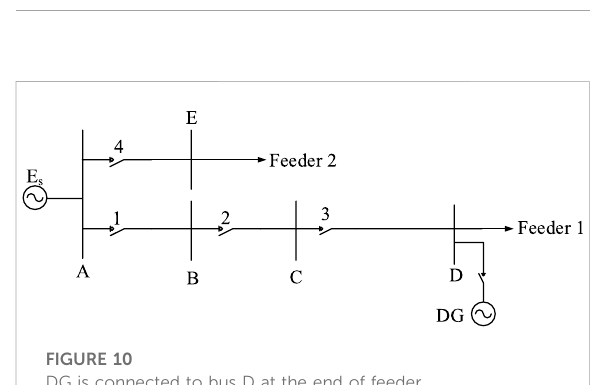
FIGURE 10 DG is connected to bus D at the end of feeder.